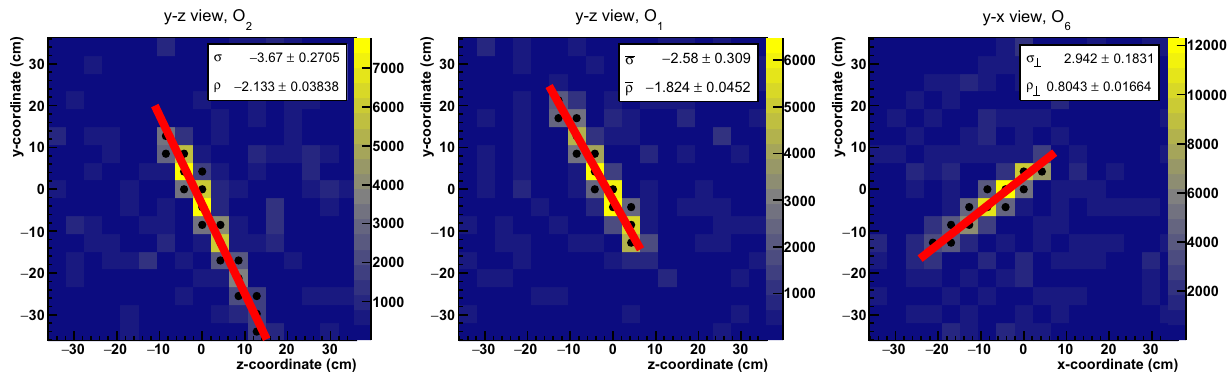
Fig. 9 Reconstructionofalineartrackonthreedifferentdetectors( O 1 , O 2 and O 6 ). The linear fit is applied to the pixels (black dots) selected according to the preliminary algorithm of signal recognition. The fit